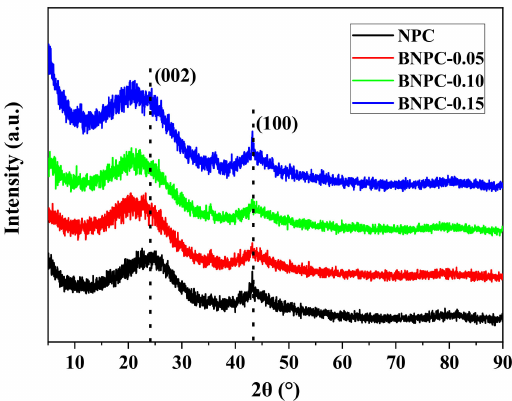
Figure 1. X-ray di ff raction (XRD) patterns of the nanoporous carbon (NPC) and boron and nitrogen co-doped nanoporous carbons